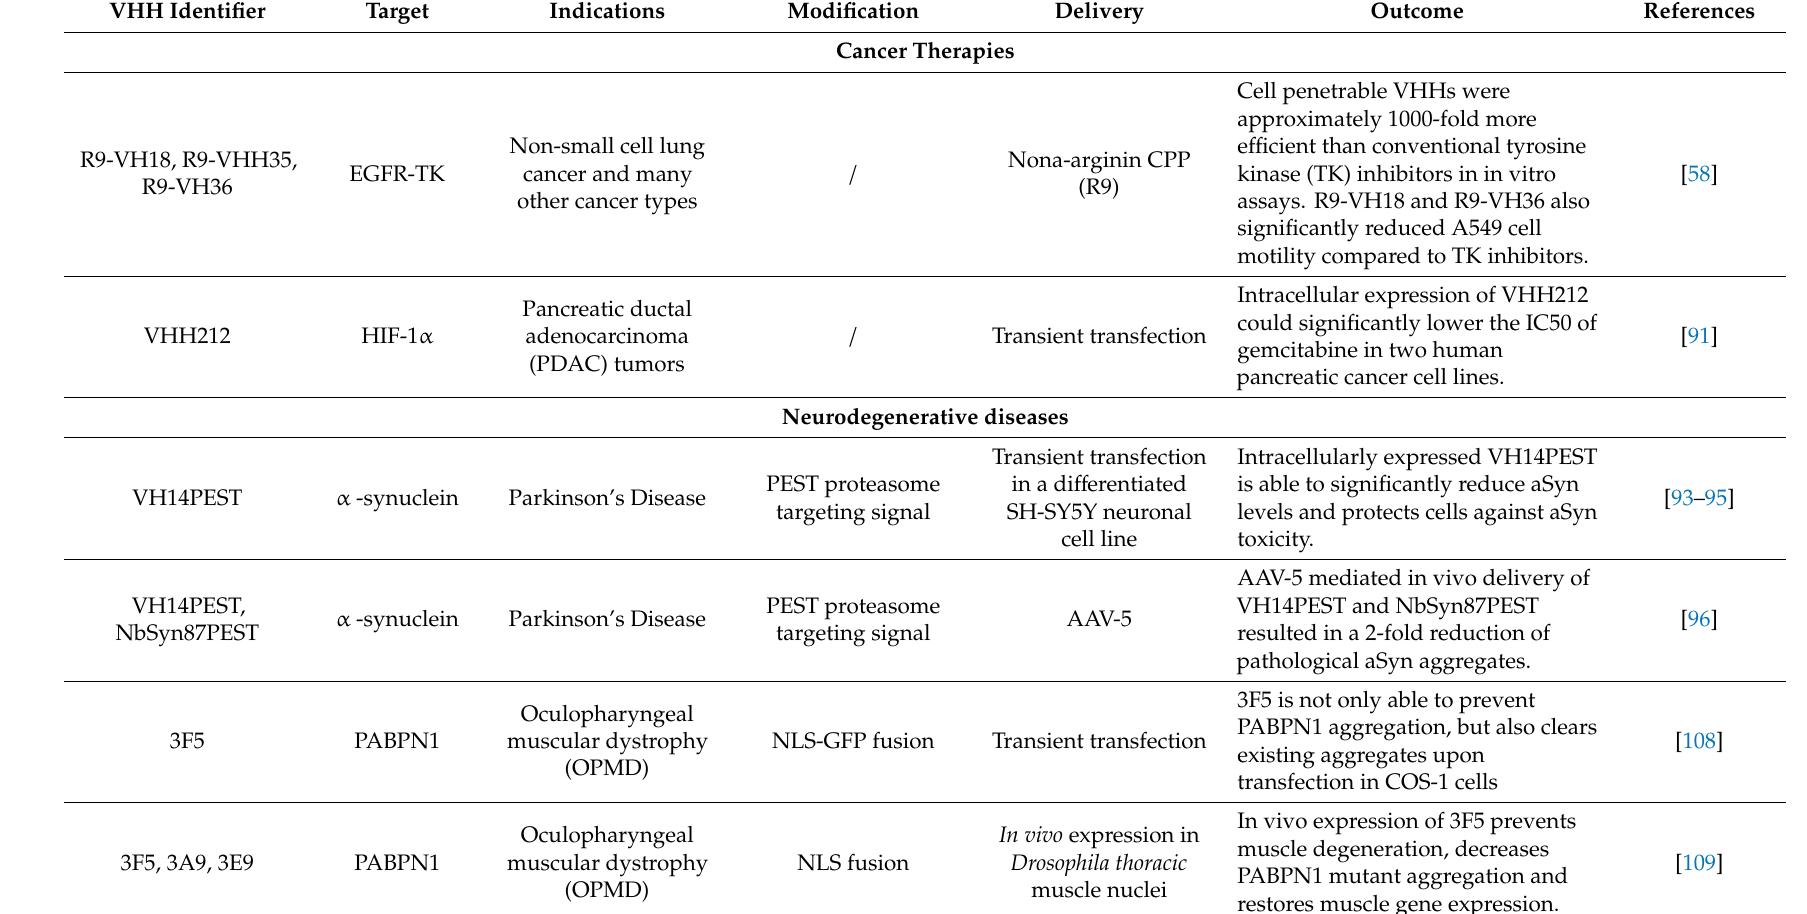
Table 1. Overview of intracellular VHHs with possible therapeutic